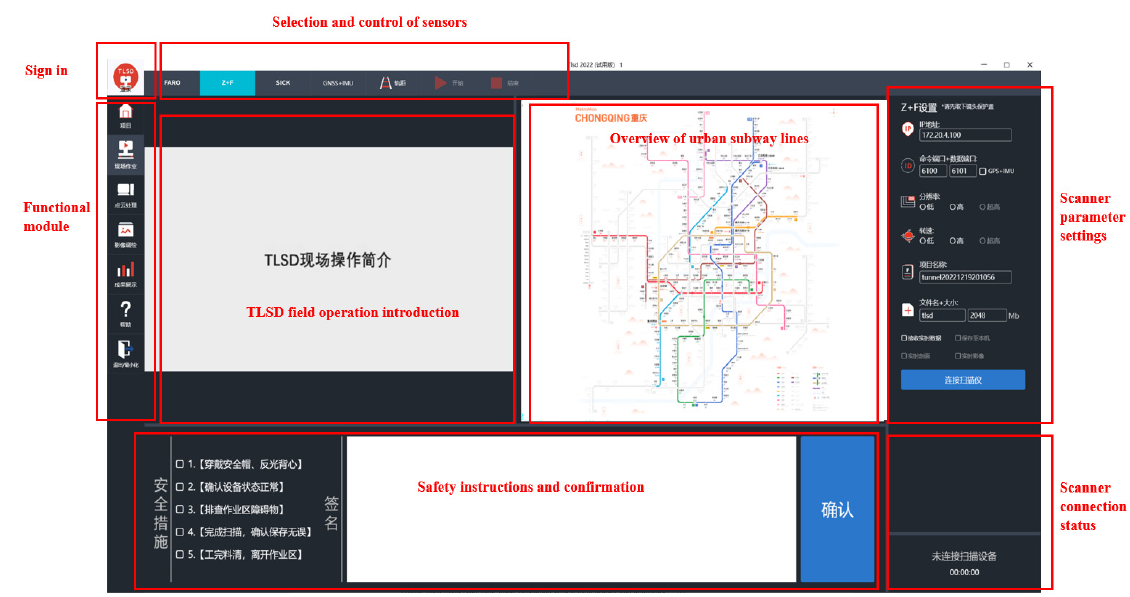
Figure 2. Software system.